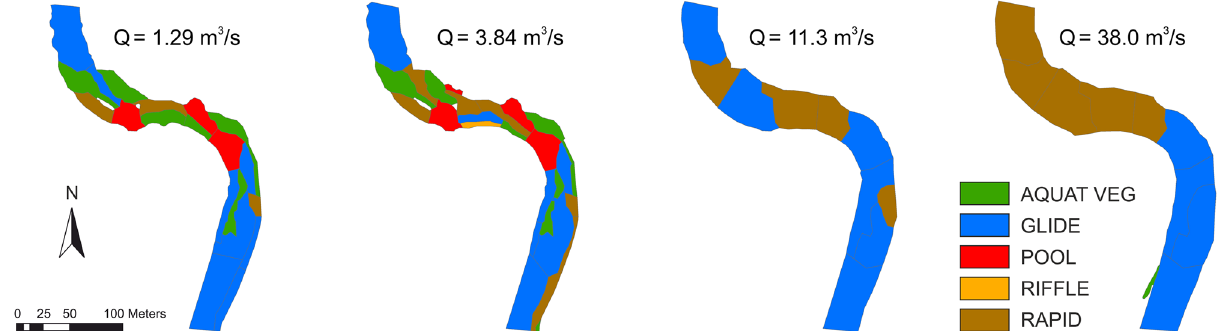
Figure 4. Distribution of hydromorphological units according to different discharge situations at the case study of